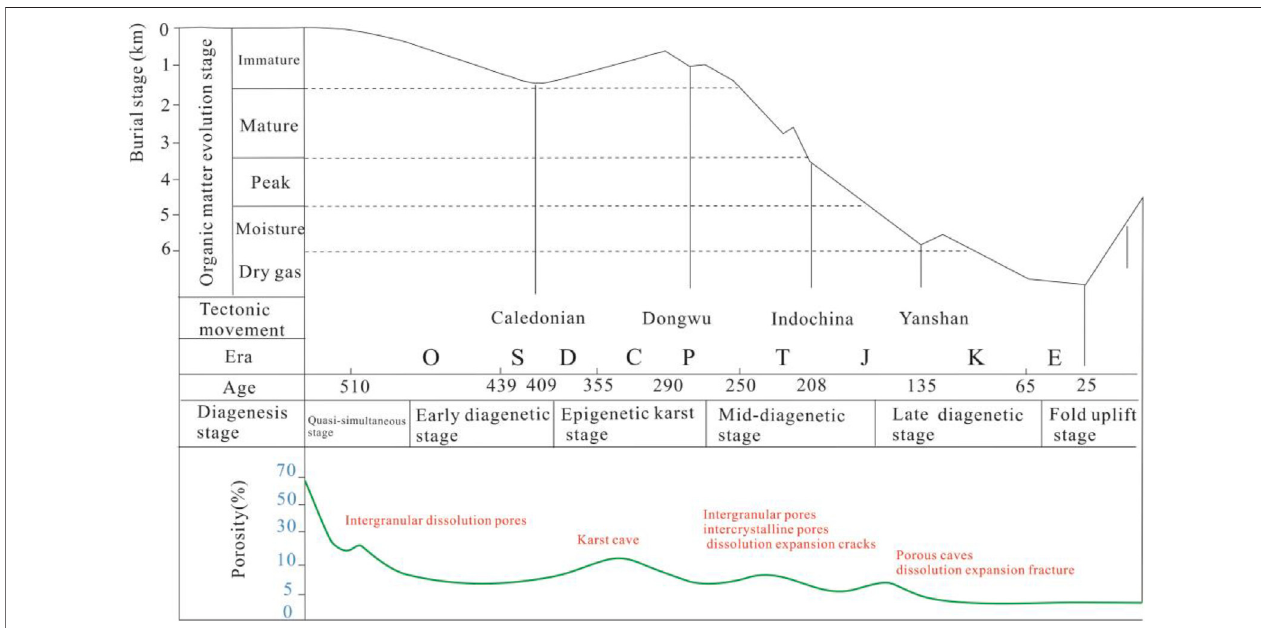
FIGURE 11 | Reservoir evolution of the Lower Cambrian Longwangmiao Formation in central Sichuan.